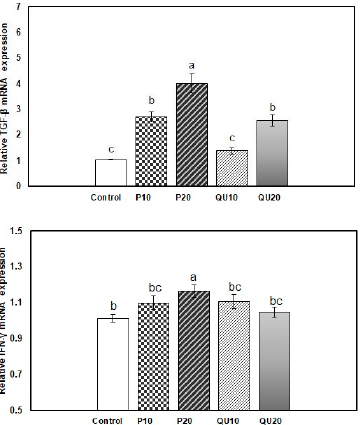
Figure 4. Relative expressions of the TGF- β and IFN- γ genes in the spleen tissue of Nile tilapia in response to PP or QU supplementation at 10% and 20% for 45 days. The expression abundance of the genes was normalized against the EF-1 α internal control gene. Values are expressed as (mean ± SE, the values not sharing a common superscript letter (a, b, c) differ significantly at p < 0.05 by one-way ANOVA followed by Tukey’s B post hoc test. PP10: prickly pear fruit peel-supplemented group (10%), PP20: prickly pear fruit peel-supplemented group (20%), QU 10 : quinoa seeds- supplemented group (10%), QU 20 : quinoa seeds- supplemented group (20%).